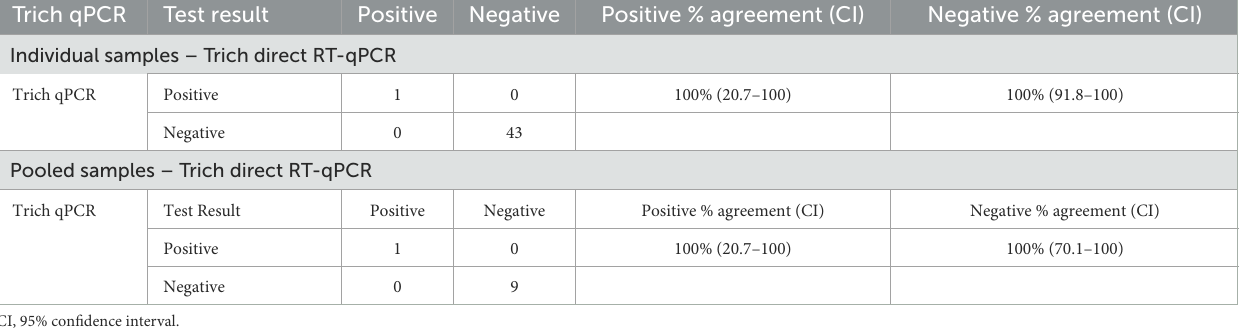
TABLE 3 Field samples were collected using PBS and TF transport tubes and validated by Trich direct RT-qPCR and qPCR for both individual and pooled samples.